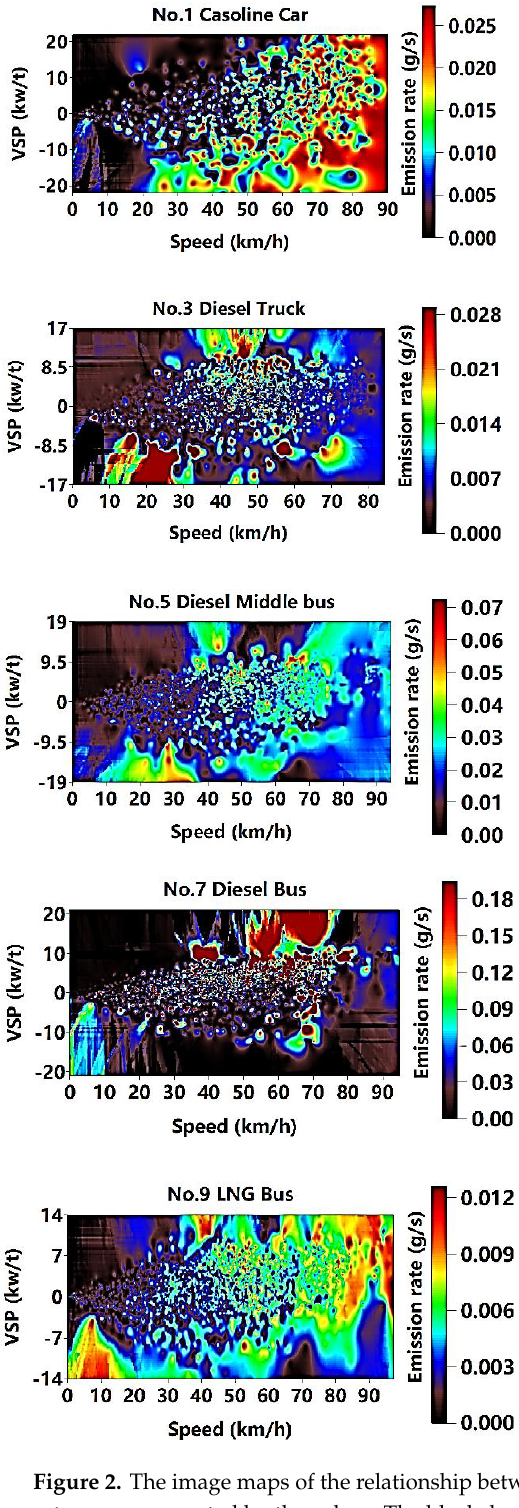
Figure 2. The image maps of the relationship between speed-VSP and CO emission rates. CO emission rates are represented by the colors. The black, brown, blue, cyan, green, yellow, orange, red, and ruby red areas indicate that the emission rates are approximately 0, 0.5, 1, 1.5, 2, 2.5, 3, 3.5, and over 4 times the average emission rate, respectively. Speed is at the X-axis, and VSP is at the Y-axis.